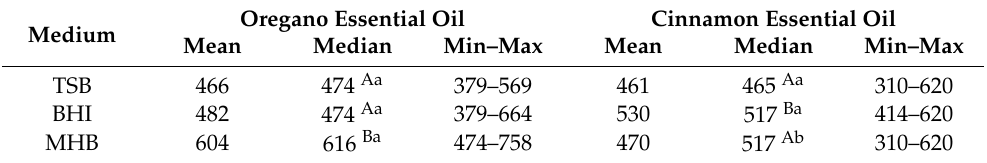
Table 1. Differences in MIC ( µ g/mL) between various essential oils and growth media ( n = 24).